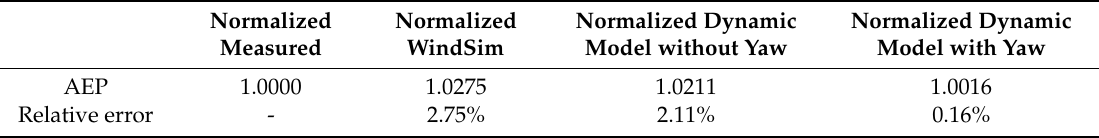
Table 3. The relative errors of the annual energy production (AEP) by the measured and other models. Normalized